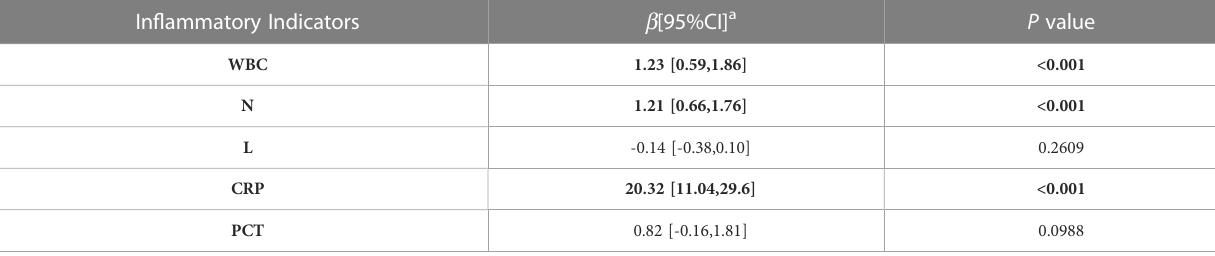
TABLE 2 Associations between in fl ammatory indicators and the burden of comorbidity. In fl ammatory